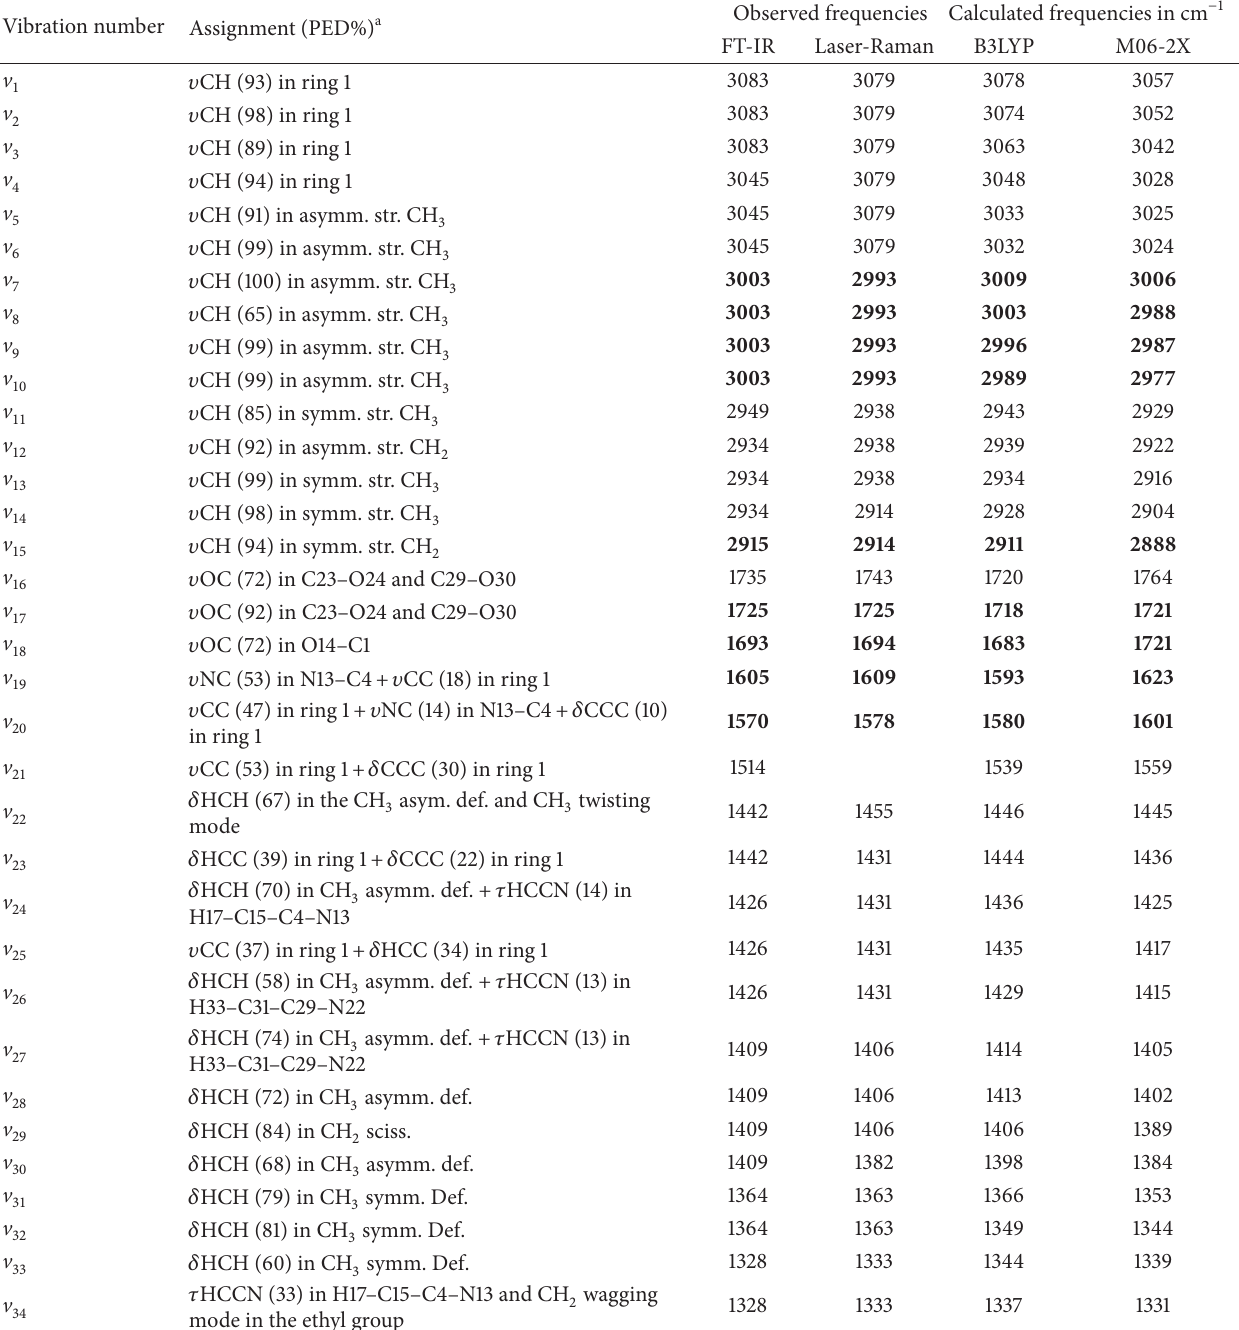
Table 2: Observed and calculated vibrational frequencies of title compound with 6-311++G(d,p). Vibration number Assignment (PED%)